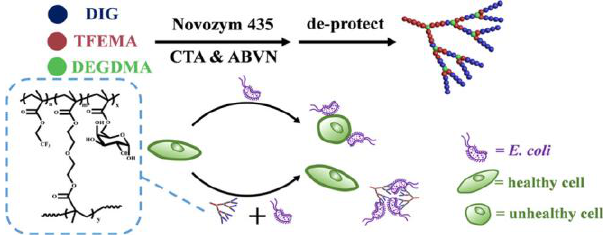
Figure 9. Binding of hyperbranched glycopolymer to Escherichia coli [51].